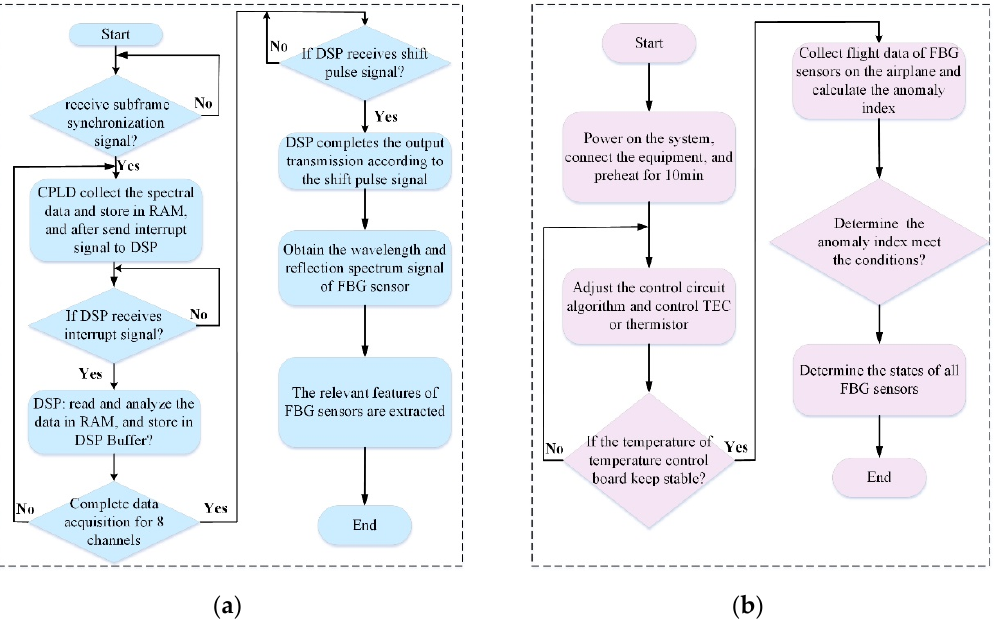
Figure 4. Program flowchart of the fault detection instrument. ( a ) FBG sensors; ( b ) FBG demodulation equipment.